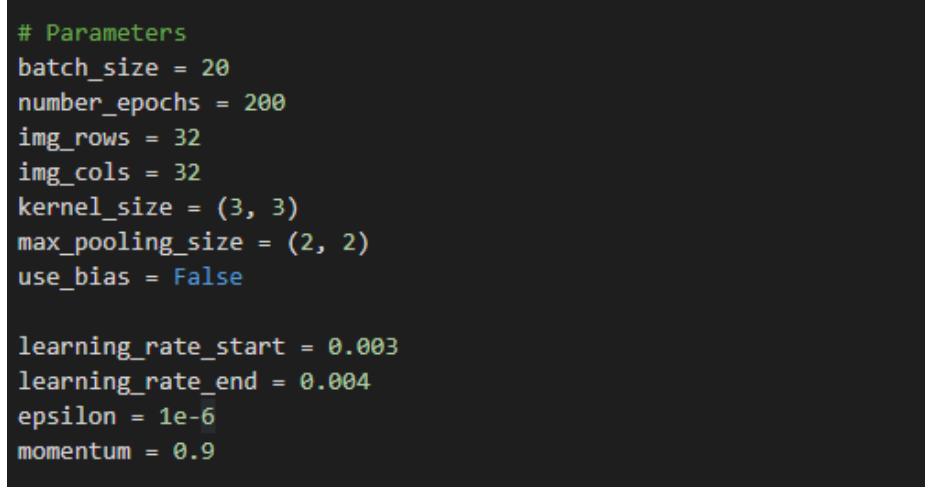
Figure 6. Definition of parameters.